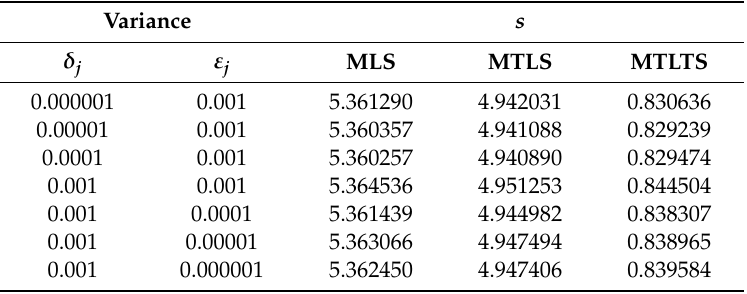
Table 1. The fitting results by three methods in Case